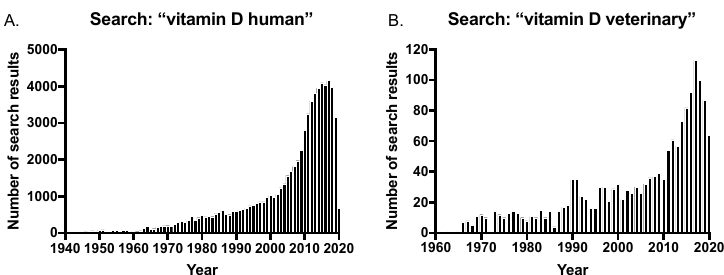
Figure 3. Number of search results in PubMed ® for searches on ( A ) vitamin D human and ( B ) vitamin D veterinary, over